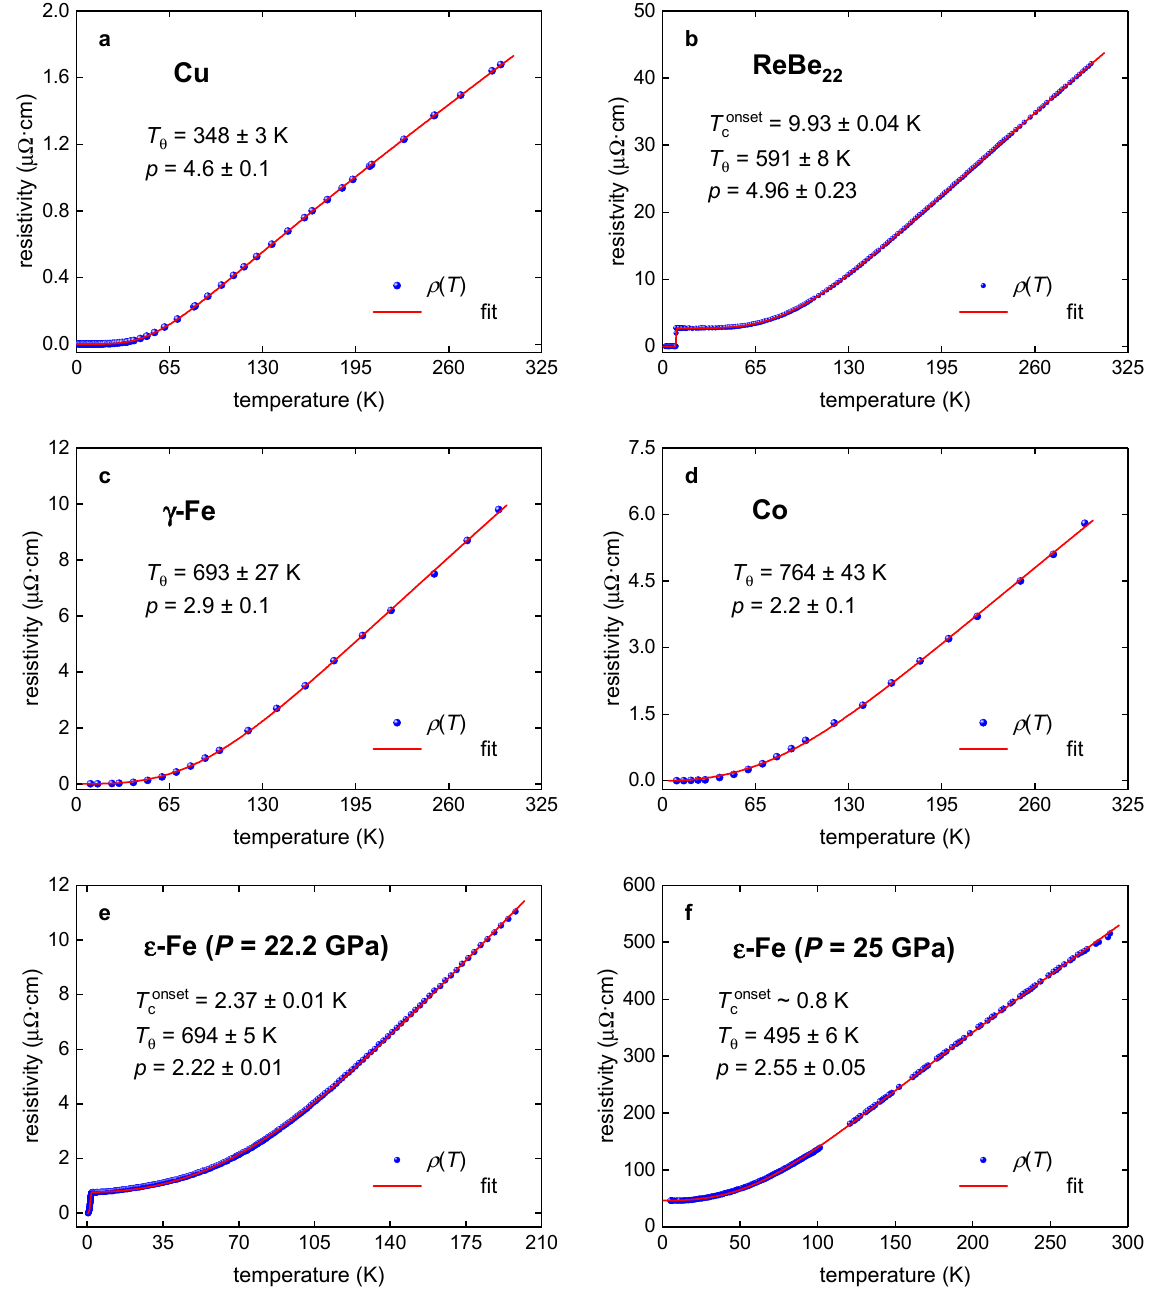
Figure 1. ρ ( T ) data and fits to generalized Bloch–Grüneisen (BG) equation (Equations (7) and (9)) for ( a ) pure Cu; ( b ) ReBe 22 ; ( c ) pure ferromagnetic γ -Fe; ( d ) pure ferromagnetic Co; and ( e , f ) pure non-ferromagnetic highly-compressed ε -Fe. The raw data are reported in [34,37,40,42,44]. The red is the fitting curve, and 95% confidence bands are shown by a pink shaded area. Goodness of fit for all plots is better than R = 0.9990.